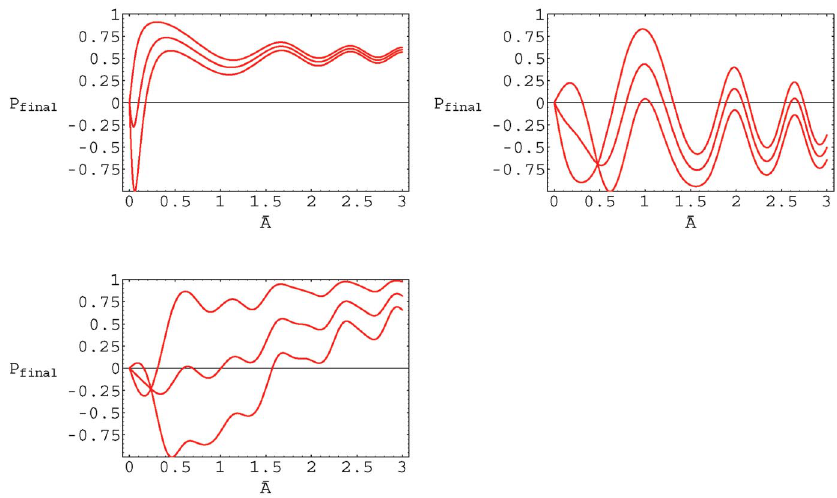
FIG. 12. (Color) Final polarization after triple crossing a resonance in the pattern of Fig. 10 as function of (cid:5) A for three different values of (cid:5) (cid:3) .